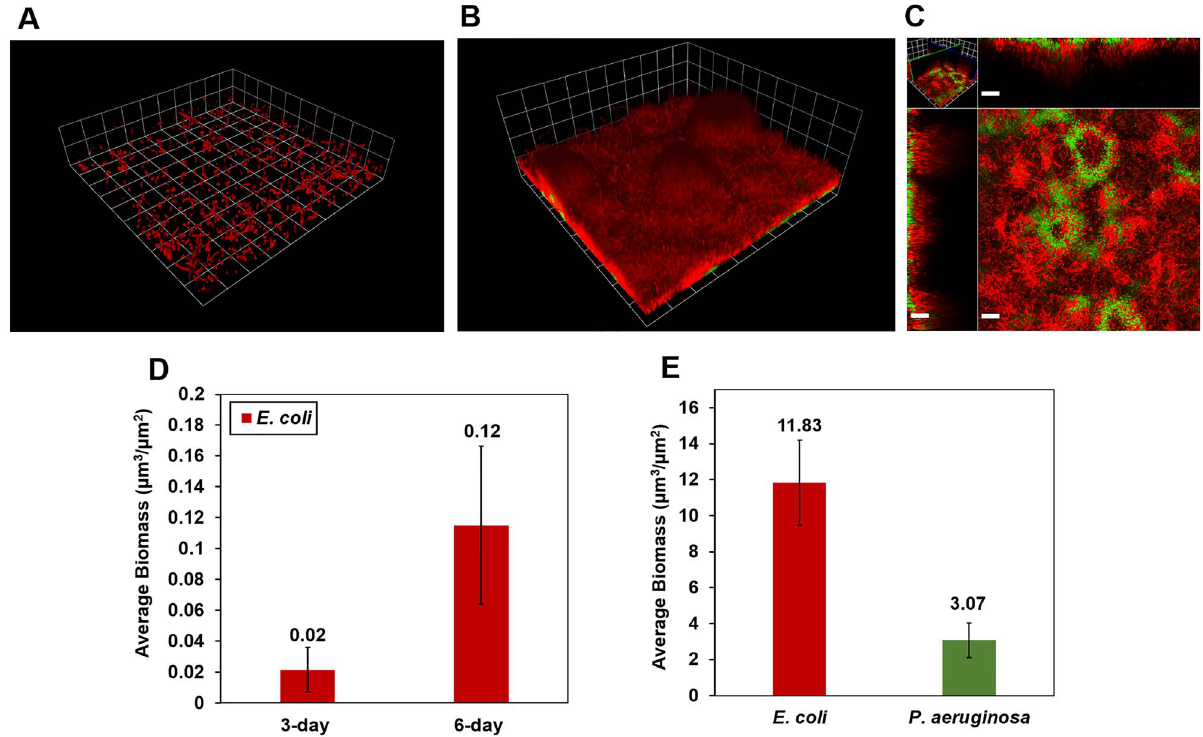
Figure 7. Colonization of E.coli biofilms by P.aeruginosa in R2A medium. E. coli appears red and P. aeruginosa -GFP appears green or yellow. A) After 3-days of mono-species growth, E. coli formed sparse biofilms composed of small, isolated cell clusters (grid unit is 23.8 m m). B) Mixed P. aeruginosa and E. coli biofilm on day 6, after 3 days of mono-species E. coli growth plus 3 additional days of multi-species growth after inoculation of P. aeruginosa . (grid unit in B is 23.8 m m). Following introduction of P. aeruginosa , E. coli grew prolifically and adopted a configuration similar to that observed in other mixed-species experiments. C) Horizontal section near the base of the biofilm and vertical sections of the biofilm shown in panel B (scale bar=20 m m). D) Biomass of 3-day- and 6-day-old E. coli mono-cultured biofilms. E) Biomass of co-developed biofilms after 3 days of E. coli growth plus 3 additional days of multi-species growth after inoculation of P. aeruginosa .